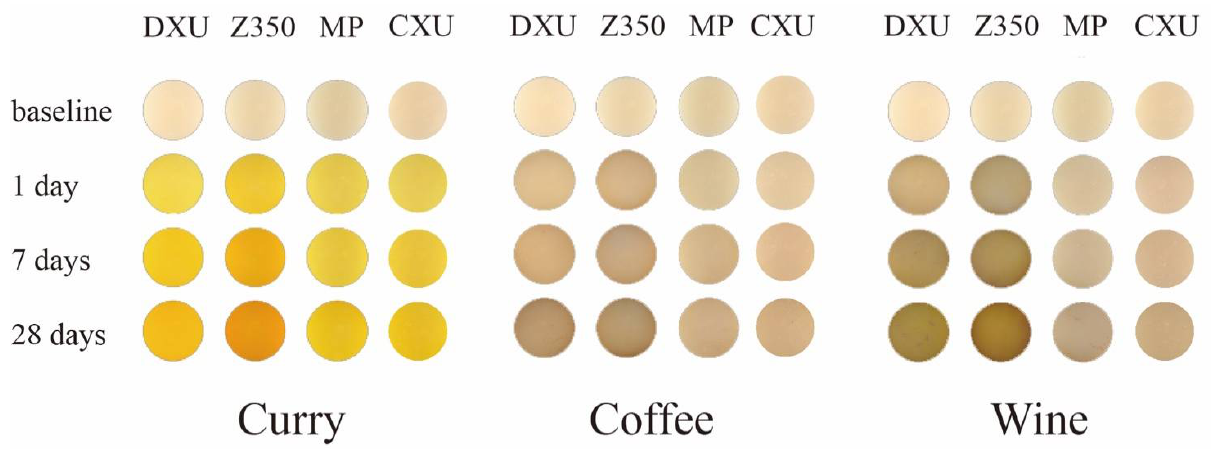
Figure 2. The staining situations of four representative material samples in each staining solution.